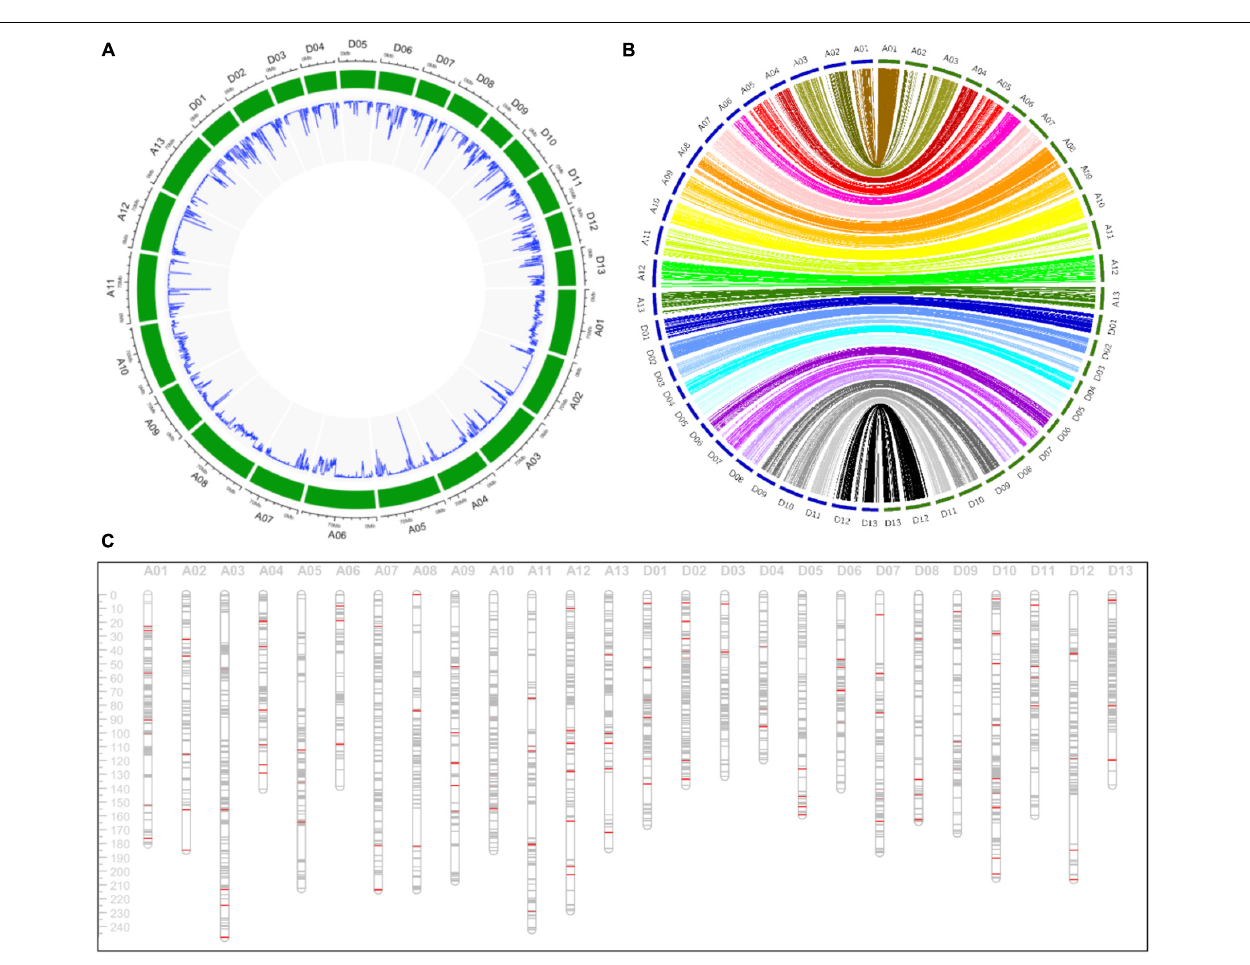
Frontiers in Plant Science |